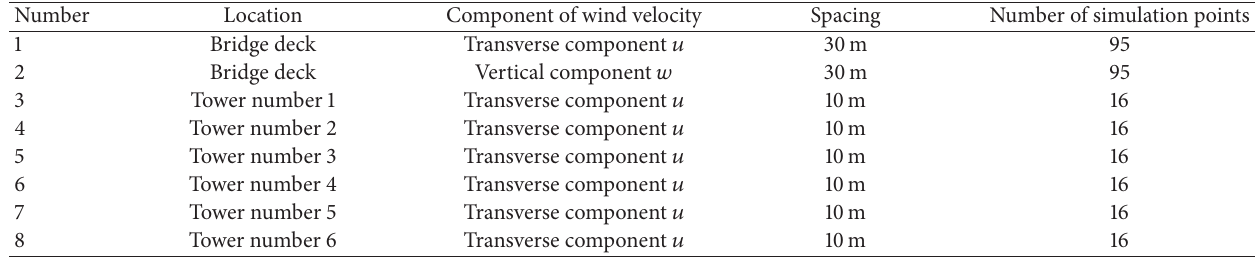
Table 2: Simplified simulation of the wind field.